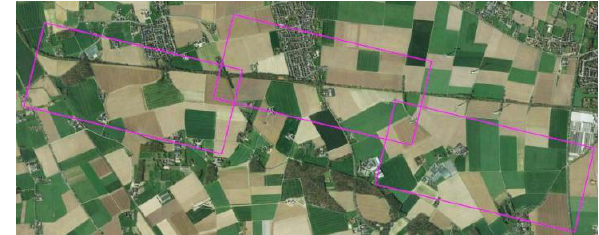
Figure 2: Footprints of Skysat Basic images of the above constellation in Google Earth based on JASON-files The focal length of the camera is 3.6m. The pixel size is not published by Planet, but the published footprint size of the multispectral pixels corresponds to a pixel size of 6.5µm. Reverse the flying height, determined by resection based on ground control points (GCPs) and controlled by the orbit altitude results in a pixel size of 6.35µm. Rational polynomial coefficients (RPCs) are distributed together with the images. For the orientation, this does not require the knowledge of the pixel size. For control reasons, the orientations were also determined by resection, but for the very narrow field of view of 0.26° x 0.11°, the 2.4% difference in pixel size does not affect the horizontal coordinates determined by resection.